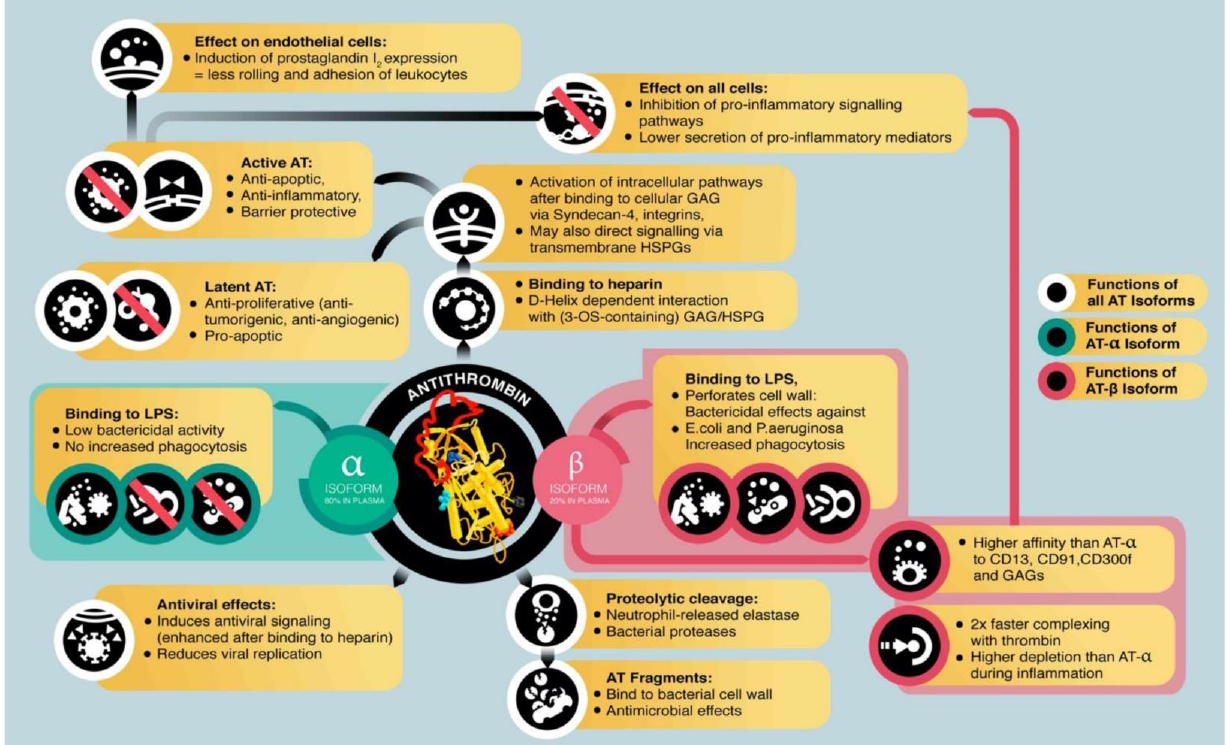
Figure 2. Functions and effects of antithrombin in host defense and inflammation. Note: AT, an- tithrombin; LPS, lipopolysaccharide; HSPG, heparan sulfate proteoglycans; GAG, glycosaminogly-